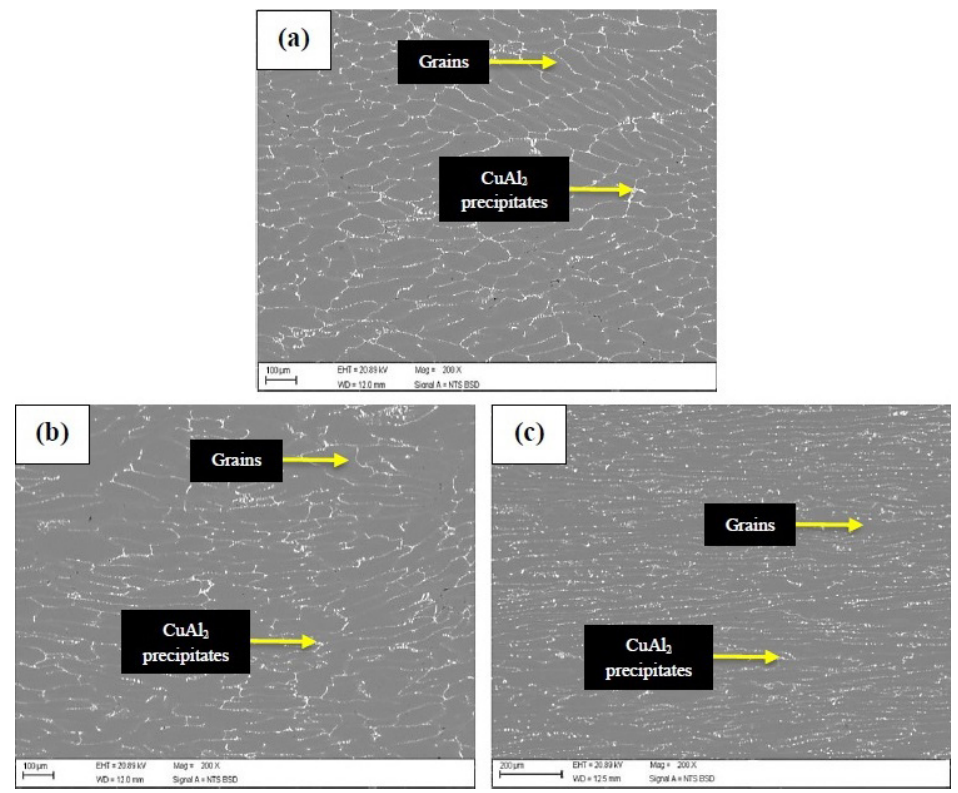
Figure 3. Microstructure of the Al4.5wt%Cu alloy after conventional solidification and RA of (a) 54% (b) 76% (c) 91%.